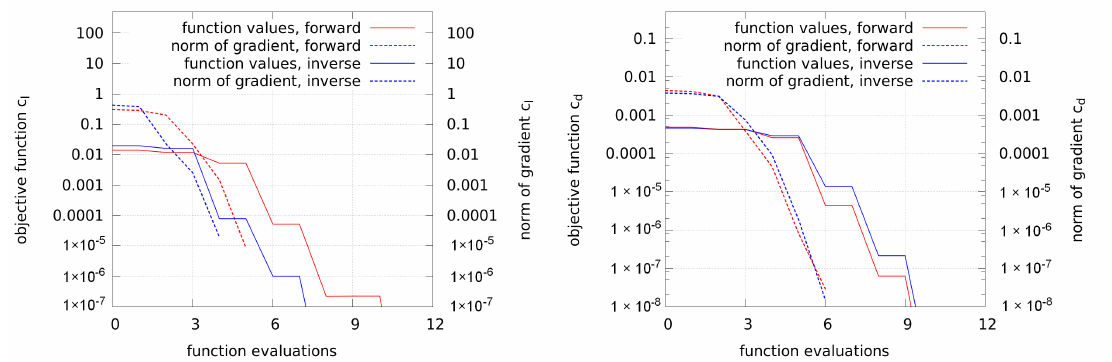
Figure 5. Objective functions as in Equation (14) and norm of the gradient for the lift objective and drag objective along the number of function evaluations.